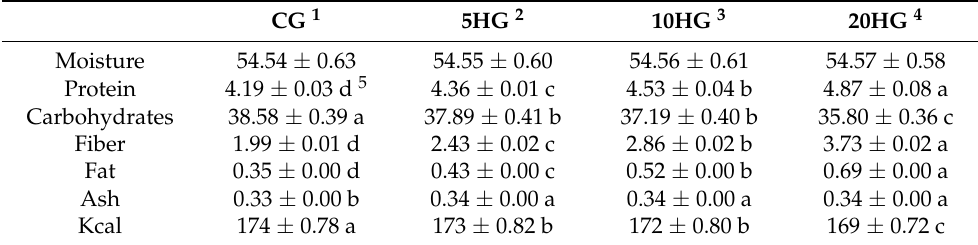
Table 3. Nutrient content (%) of control and hemp seed flour-enriched gnocchi